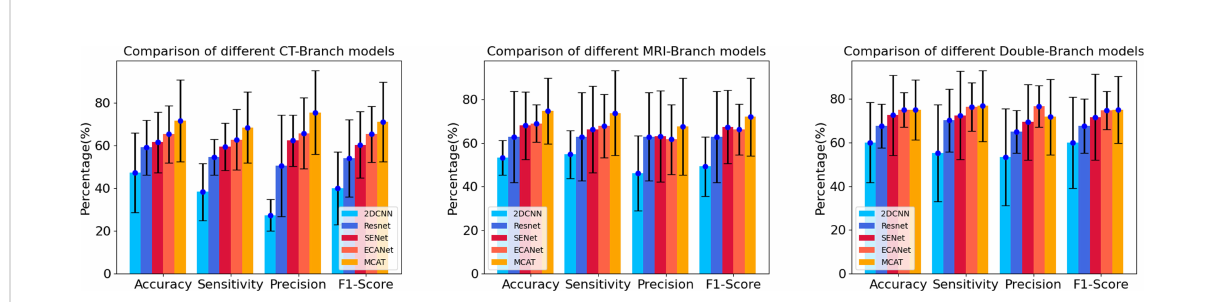
MVI, microvascular invasion; HCC, hepatocellular carcinoma; 2DCNN, two-dimensional convolutional neural networks; ResNet, residual neural network; SENet, squeeze-and-excitation Networks; ECANet, ef fi cient channel attention network; MCAT, multimodality-contribution-aware TripNet; AUC, the areas under the receiver operating characteristic curves; a, comparison AUC value of CT branch between 2DCNN, ResNet, SENet, ECANet and MCAT respectively; b, comparison AUC value of MRI branch between 2DCNN, ResNet, SENet, ECANet and MCAT respectively; c, comparison AUC value of double branch between 2DCNN, ResNet, SENet, ECANet and MCAT respectively; d, comparison AUC value of MCAT model between CT branch, MRI branch and double branch respectively.